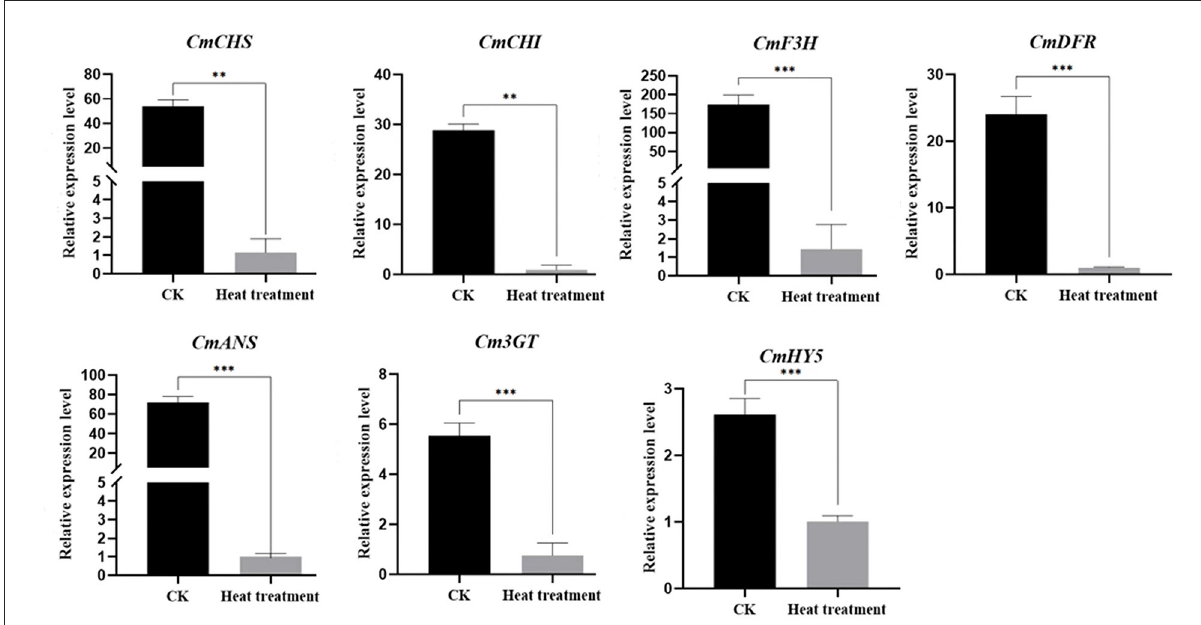
FIGURE7 Verification of the relative expression of anthocyanin metabolism gene following high-temperature treatment. Values are presented as mean ± SE ( n = 3). **Significant at P < 0.01 and ***significant at P < 0.001, as determined by Student’s t